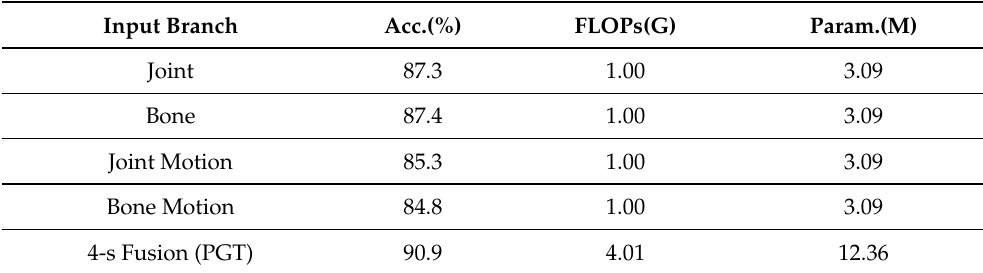
Table 3. The ablation study on the NTU-RGBD 60 CS benchmark denoting the effect of the four-stream fusion strategy.